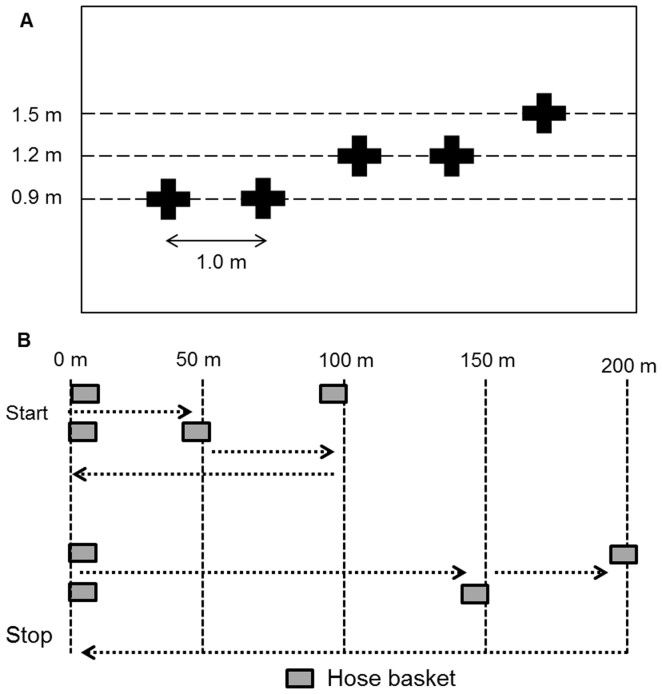
Schematic view of thevehicle extrication and carrying hose basket over terrain tasks.The work tasks were separated by 10 minutes of rest.